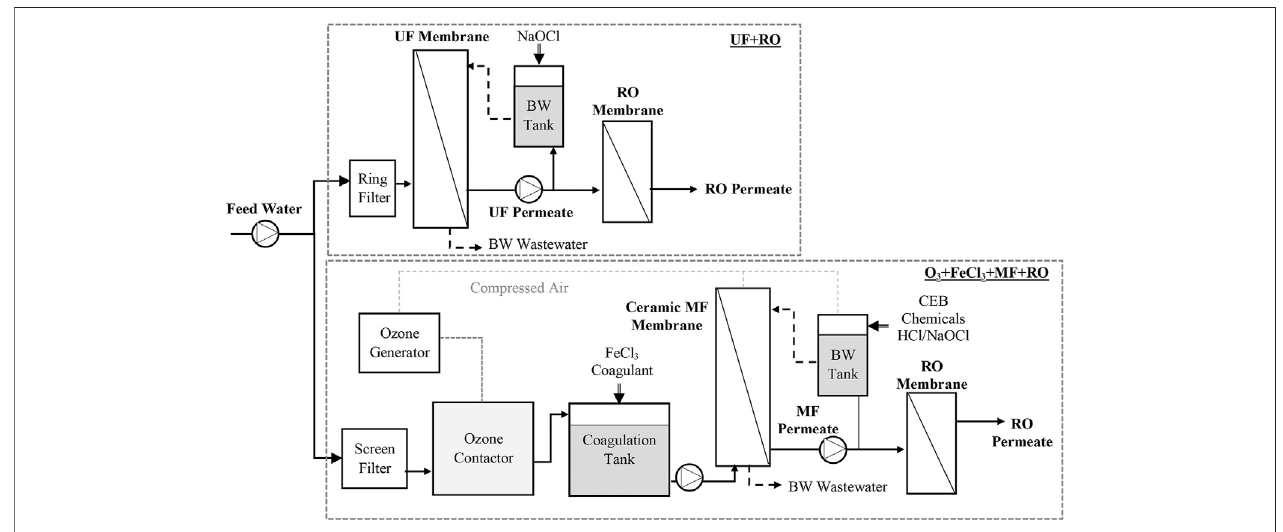
FIGURE 2 | Schematic of the two tertiary treatment systems, adapted from Lehman and Liu. (2009).